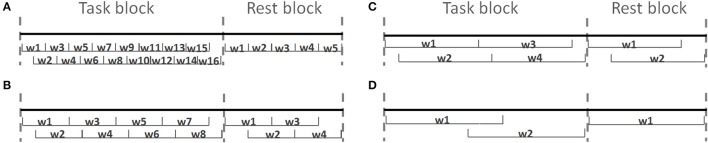
Four different epoch styles based on length of windows. The task and rest blocks are divided into (A) 5, (B) 10, (C) 20, and (D) 25 s windows (wi).